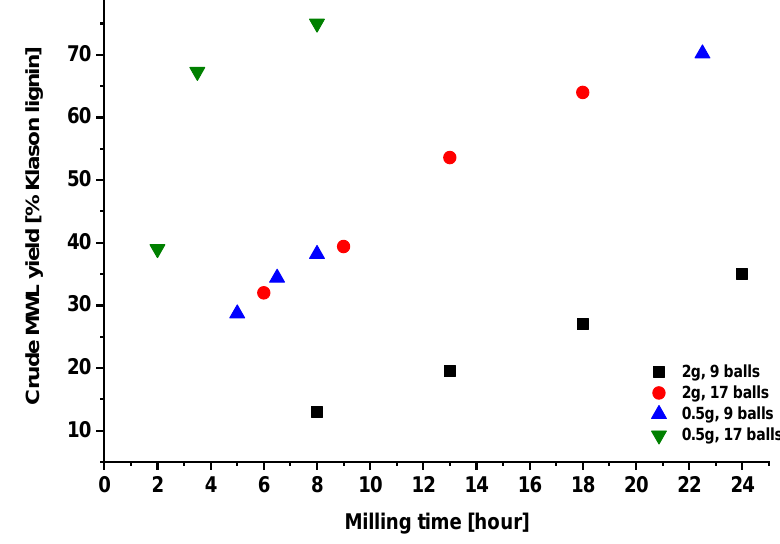
Figure 1. The effect of the number of balls and amount of wood material used per milling container.